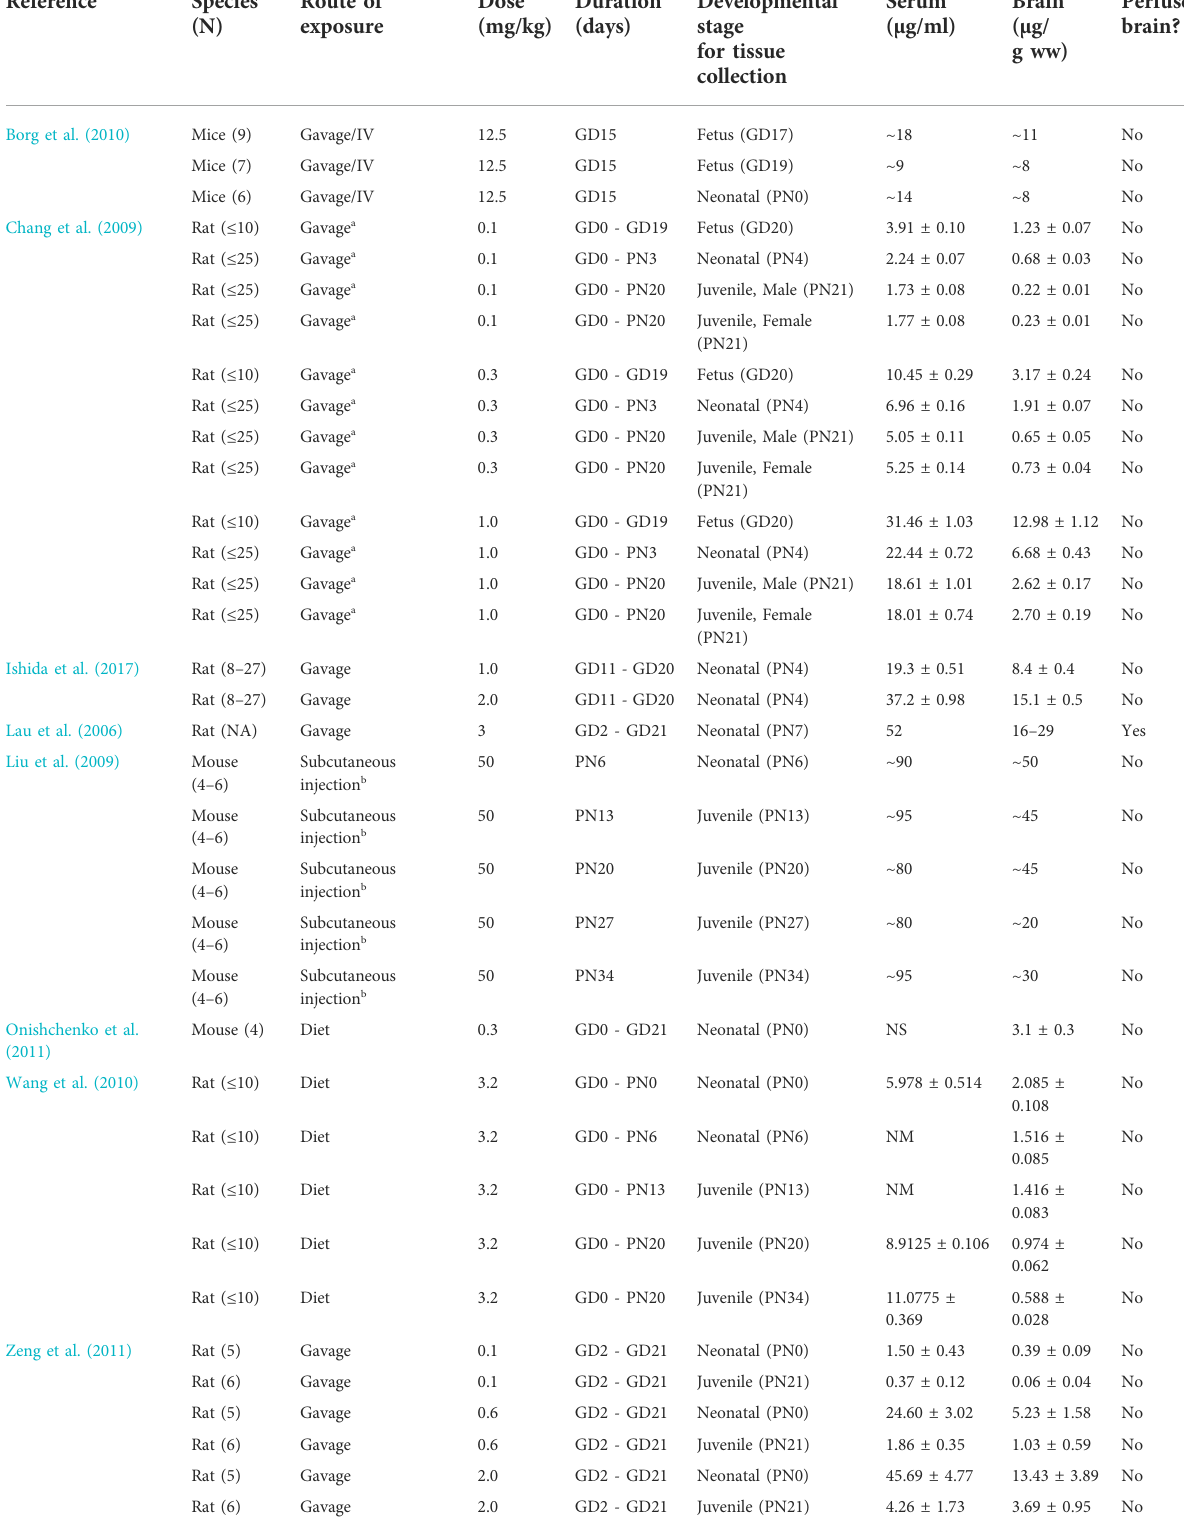
TABLE3Pregnantanddevelopinglaboratoryanimalswereexposedtoper fl uorooctanesulfonicacid(PFOS)throughdifferentexposureroutes,doses, and durations as provided